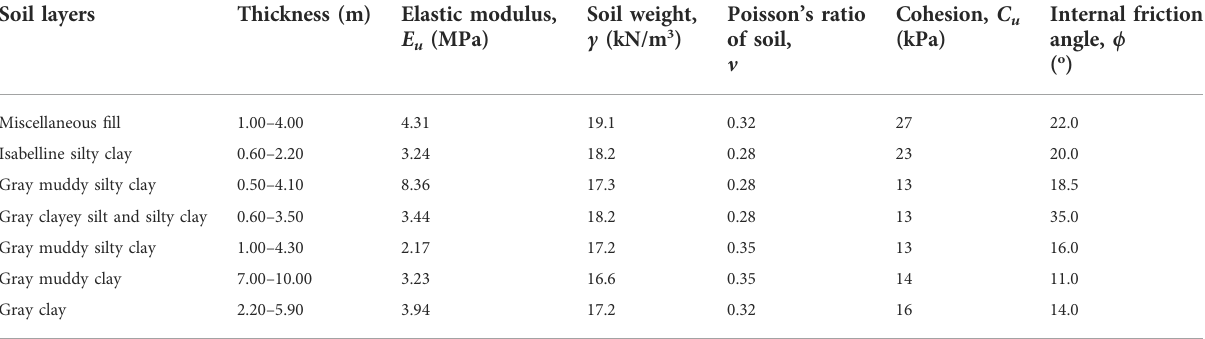
TABLE 4 Soil conditions in the project of lot 9 of Shanghai metro line 6 (Zeng et al., 2016).